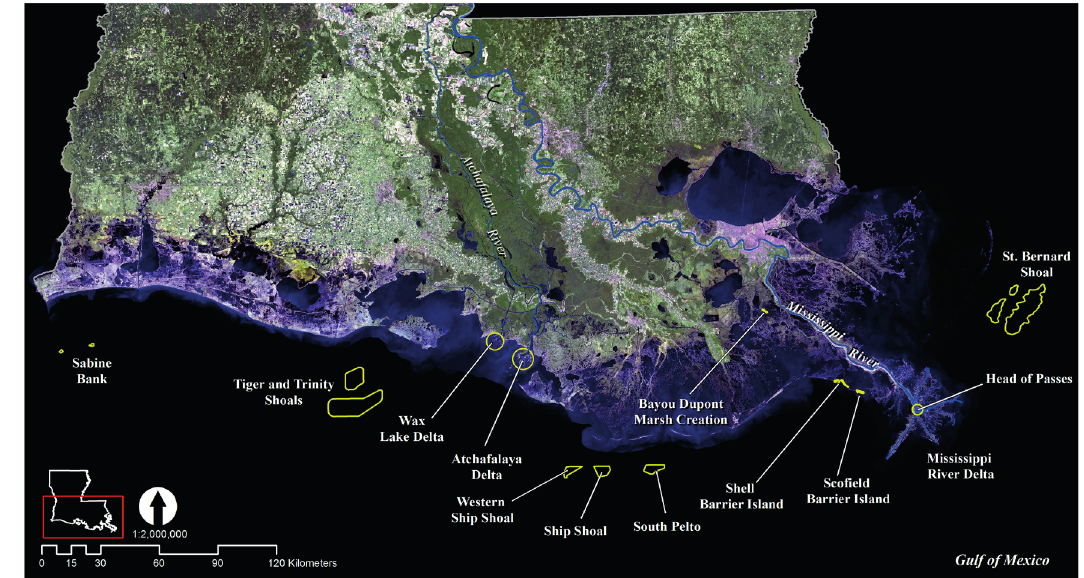
Fig. 1 Map of coastal Louisiana showing locations of various offshore sand sources, barrier island restoration, and marsh creation